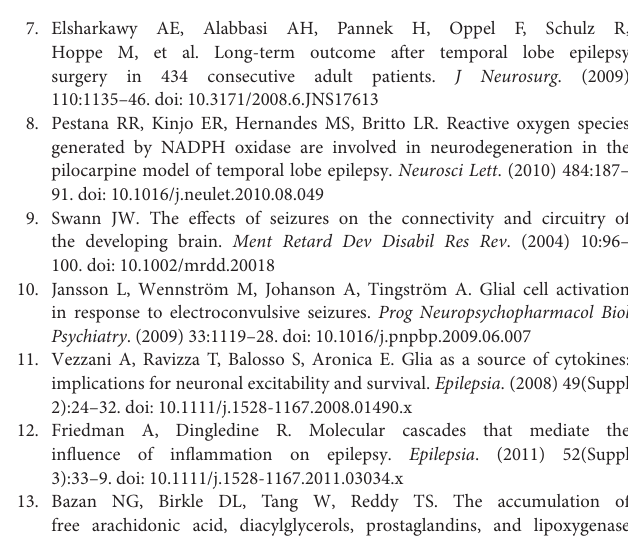
Figure S1 | A representative diagram of all steps of the experimental design, the number of animals used in each group/time point